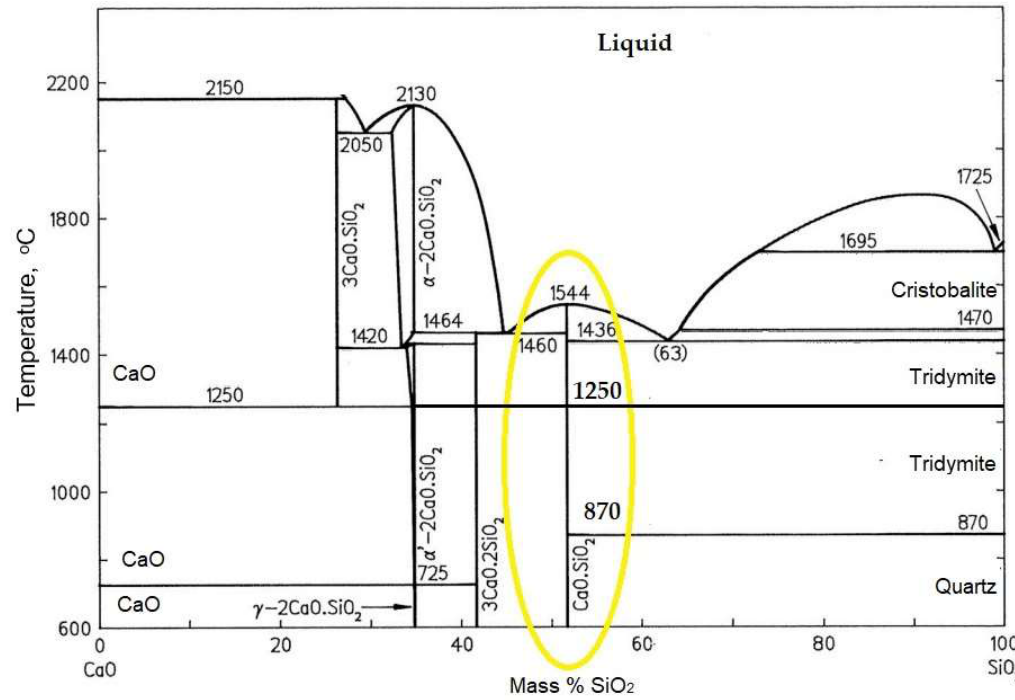
Figure 4. Phase diagram of the CaO–SiO 2 system.